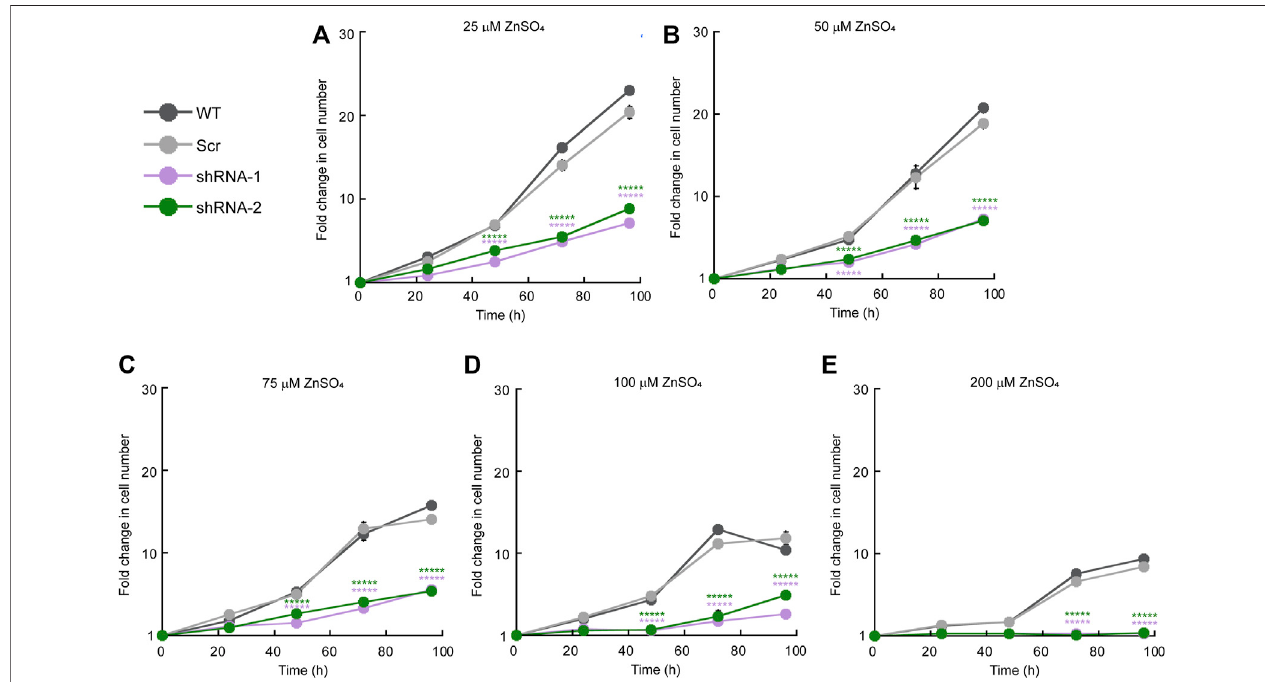
FIGURE3| ZIP11 knockdownresultsinelevatedsensitivitytoZninHeLacells.CellcountingassayofproliferatingWT,andcellstransducedwithscrambledshRNA (shRNAScr),or ZIP11 shRNAsculturedfor96 hwithincreasingconcentrationsofZnSO 4 . (A) 25 µM. (B) 50 µM. (C) 75 µM. (D) 100 µM. (E) 200 µM.Cellswereseeded at 1 × 10 4 cells/cm 2 and the growth for each clone and timepoint was normalized to the seeding density. The data represents the mean ± SE for three independent experiments. ***** p < 0.00001.